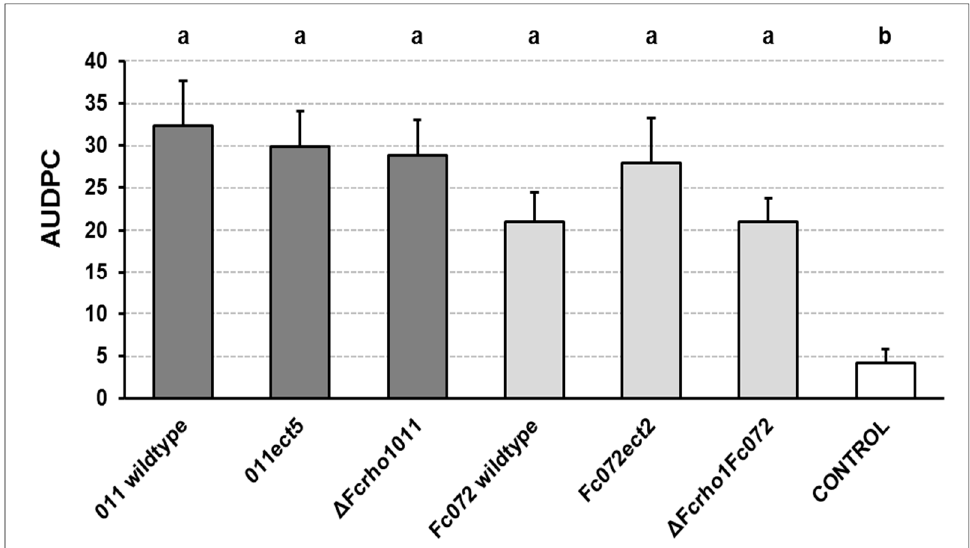
Figure 4. Area under the disease progress curve (AUDPC) of different fungal strains 30 days post inoculation (dpi). Lower-case letters (a–b) indicate significant differences (Dunn’s test, p < 0.05). Comparisons between fungal strains are indicated by color of plot. Mean values and standard error are shown.